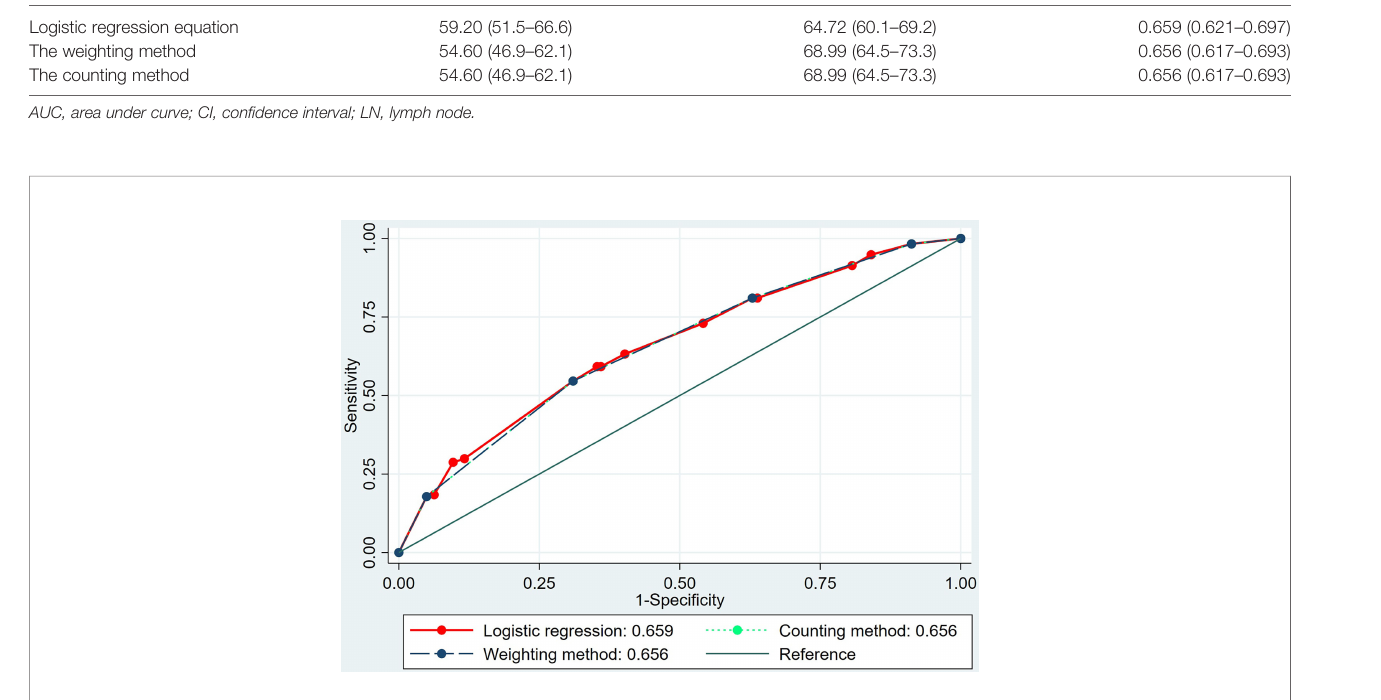
TABLE 7 | Proportion and odds ratios for each risk grade in negative and positive LN metastasis groups. Risk grade